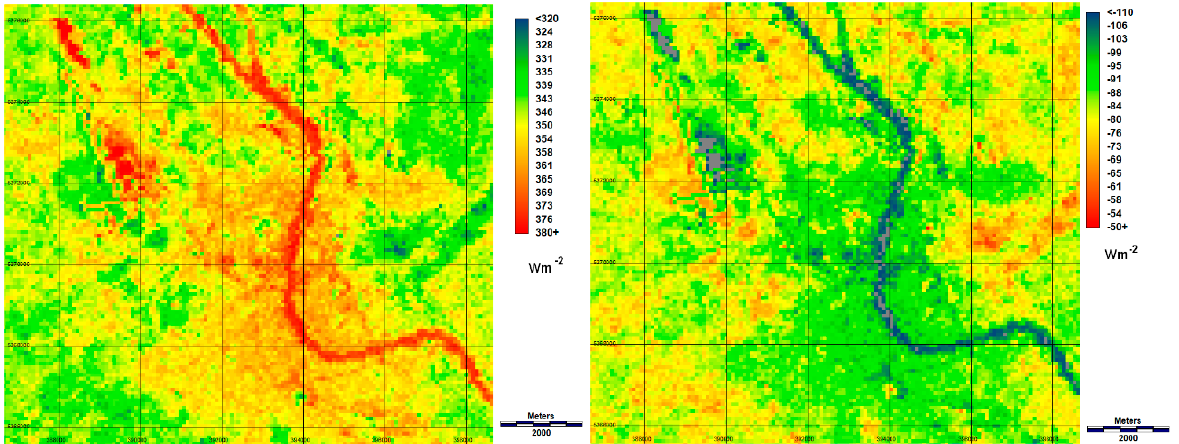
Figure 7. Longwave terrestrial emission ( left ) and net radiation ( right ) on 13 May 2012, at 21:12 UTC in the city of Basel, Switzerland. Data in Wm − 2 .